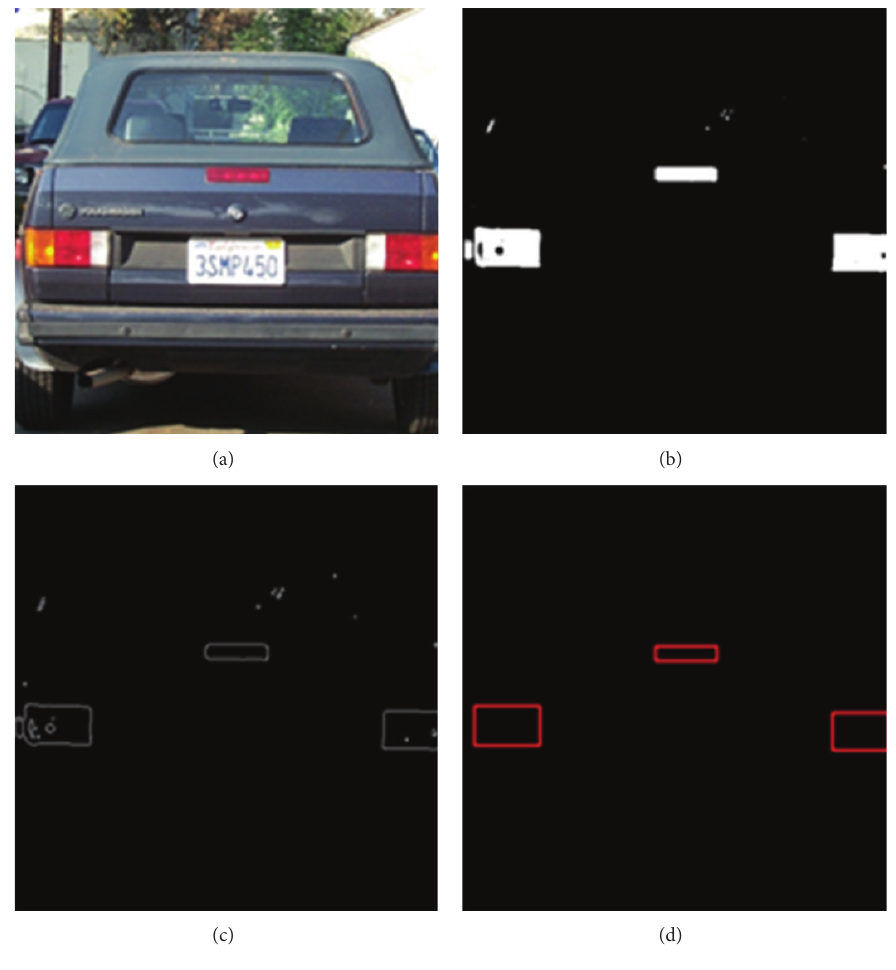
Figure 4: Extraction of taillight